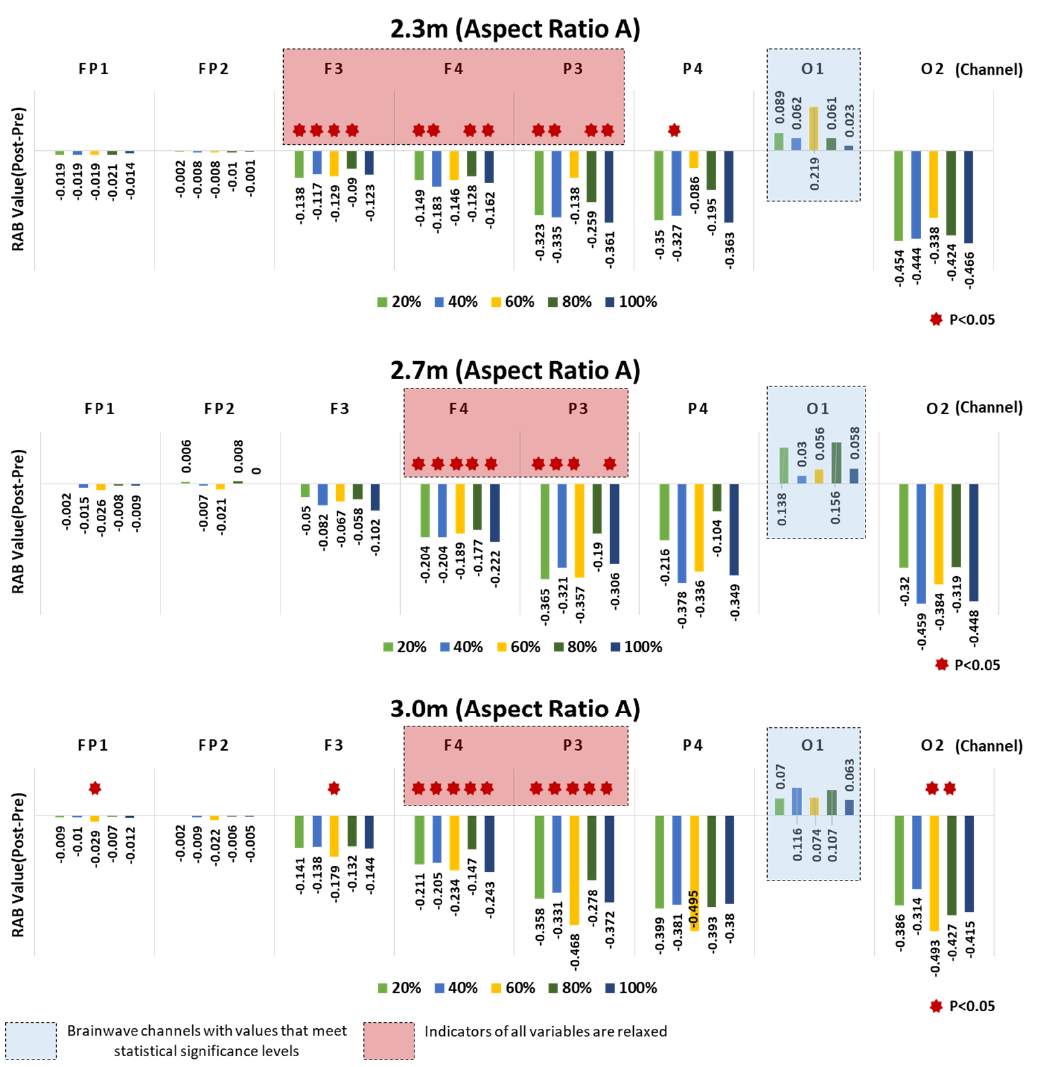
Figure 10. Aspect Ratio A—results of RAB indicator analysis for window ratio by ceiling height type.